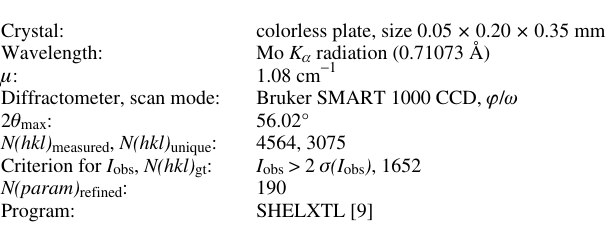
Table 1. Data collection and handling.